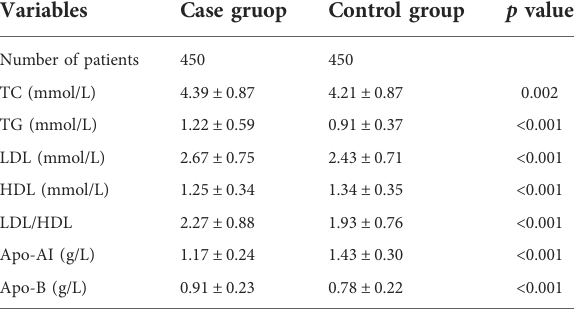
TABLE 3 Comparison of serum lipid indicators between groups.